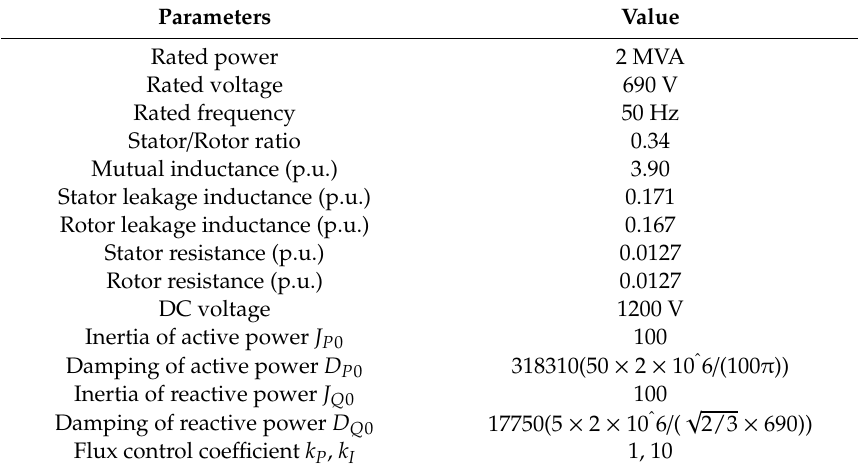
Table A1. Parameters of DFIG and VSG Control.